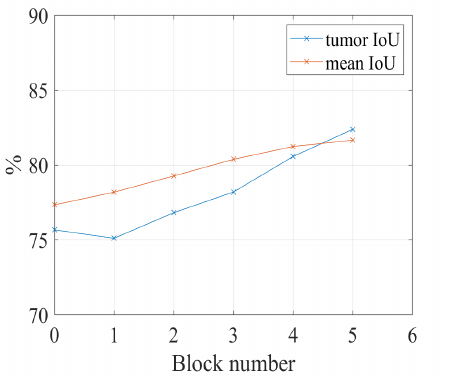
Figure 6. The relation between the number of fuzzy blocks and the segmentation performance. Block number = 1: the fuzzy blocks are applied to the first convolutional block; block number = 2: the fuzzy blocks are applied to the first and second convolutional blocks together; block number = 3: the fuzzy blocks are applied to the convolutional blocks 1, 2, and 3; block number = 4: the fuzzy blocks are applied to the convolutional blocks 1, 2, 3, and 4; block number = 5: the fuzzy blocks are applied to the convolutional blocks 1, 2, 3, 4, and 5. The reason for the maximum number of blocks is 5 will be given in Section